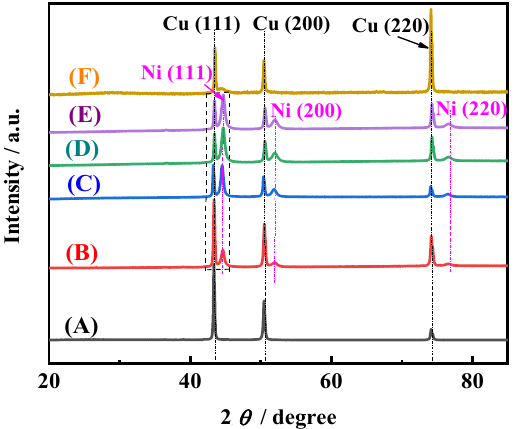
Figure 7. The XRD patterns of different films: Cu substrate (A) and Ni films electrodeposited in 0.2 M NiCl 2 , 2 M NH 4 Cl, and 1 M NaCl solutions with different pH values of 3 (B), 7.1 (C), 8.1 (D), and 9.1 (E), and with 0.1 M EDTA (F).